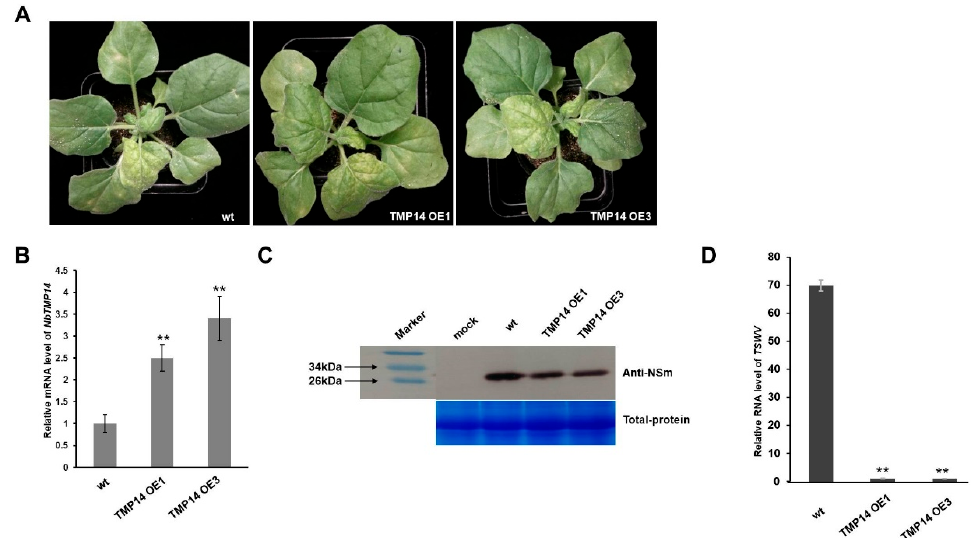
Figure 8. Enhanced TSWV resistance of N. benthamiana plants overexpressing NbTMP14 . ( A ) Symptoms of the wild-type and NbTMP14 overexpression (OE) plants (the lines TMP14 OE1 and TMP14 OE3 were randomly selected) after 15 days of TSWV infection. ( B ) Expression levels of NbTMP14 in transgenic N. benthamiana . Bars represent the mean ± standard error, ** indicates the significant differences (Student’s t -test, ** p < 0.01). ( C ) Western blot detected the differing accumulation of TSWV between wild-type and NbTMP14 OE plants. ( D ) RT-qPCR shows the accumulation of TSWV RNA between the wild-type and NbTMP14 OE plants. Bars represent the mean ± standard error, ** indicates significant differences (Student’s t -test, ** p < 0.01).